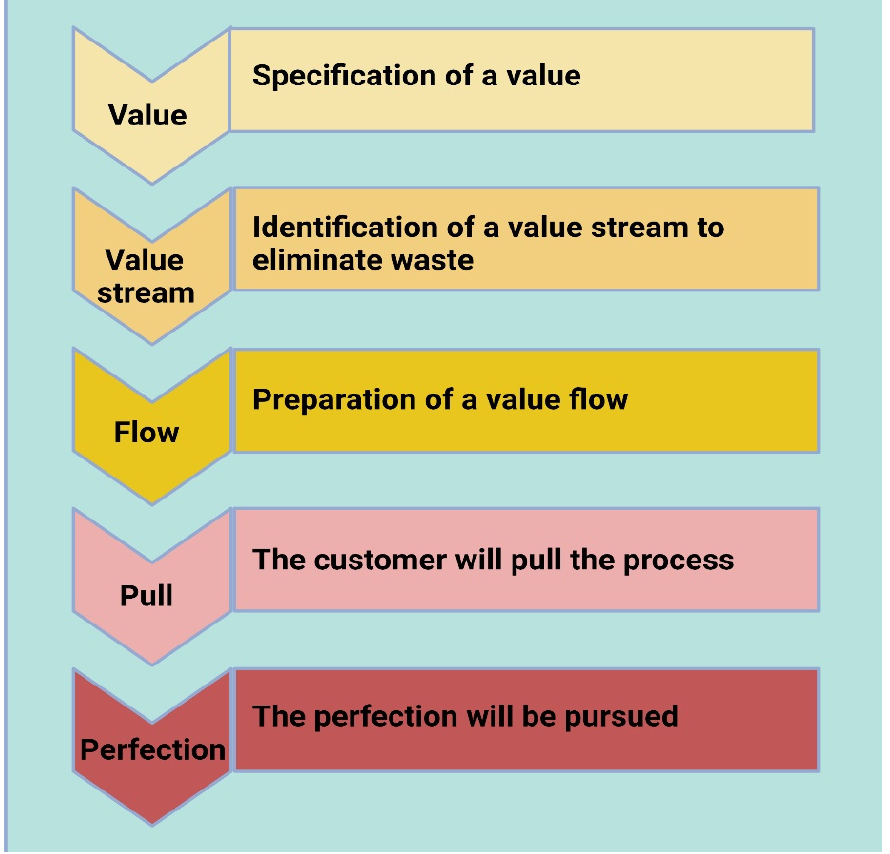
Figure 4. Lean Principles in Transactional Engineering Contexts (adapted from Womack and Jones [70] and Haques and James-Moore [9,72].